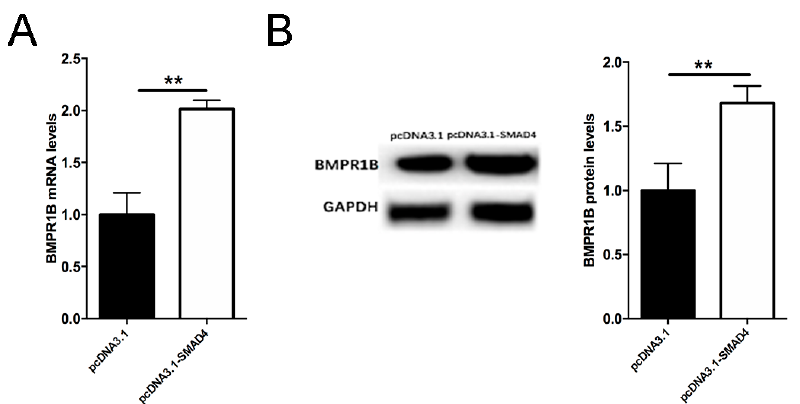
Figure 6. Smad4 induces endogenous BMPR1B expression in the ovine granulosa cells. Smad4 expression vector pcDNA3.1-Smad4 was transfected into the ovine granulosa cells cultured in vitro , and qRT-PCR and Western blotting was used to quantify mRNA ( A ) and protein ( B ) levels, respectively. Bars represent the mean ± SEM of at least three repeats. ** p < 0.01.